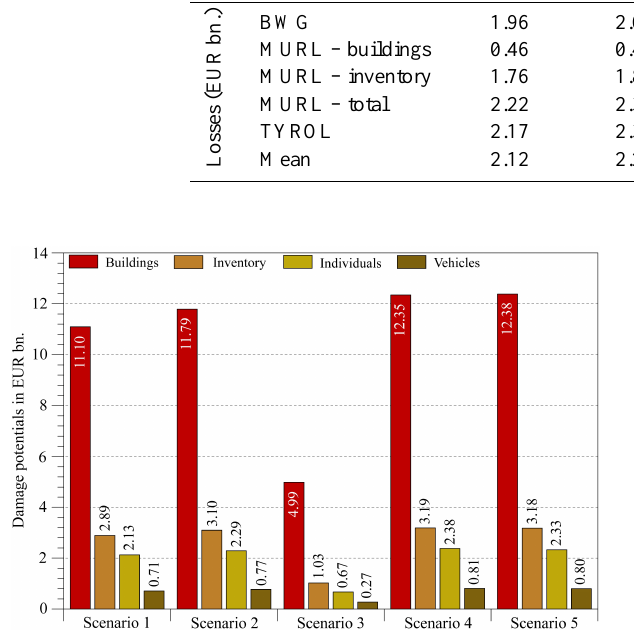
Fig. 10. Damage potentials of the different scenarios in bn. EUR. The inventory of the industry and commerce sector is included into the category of buildings (unlike the demonstration for the ESL in Table 4).